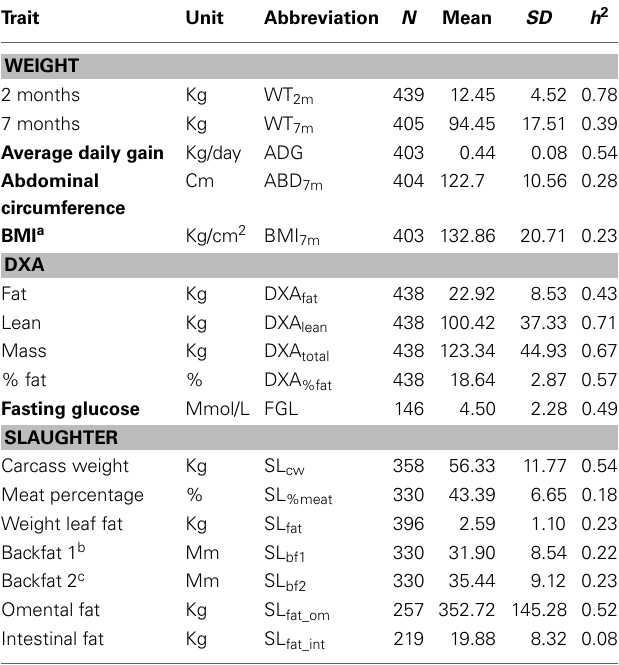
fatness-related traits in the pig resource population, as published in Kogelman et al.